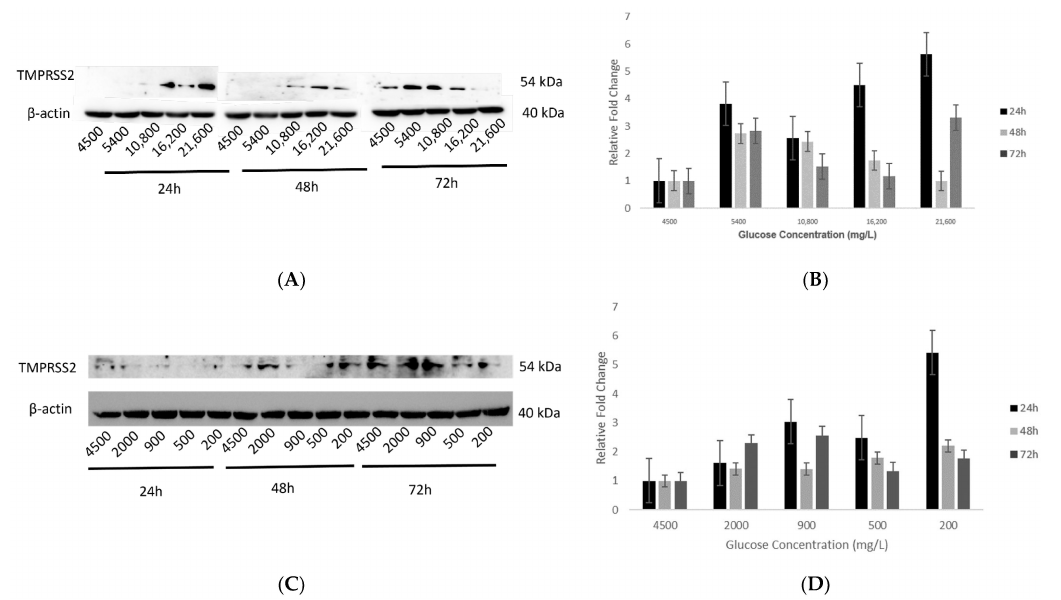
Figure 5. Protein expression of TMPRSS2 in hypothalamic neurons under various concentrations of glucose at different time points. ( A ) With increasing glucose concentrations (mg/L) of 5400, 10,800, 16,200, and 21,600, protein expression of TMPRSS2 (54 kDa) showed an increase after 24h, which with longer exposures of 48 and 72 h, decreased as compared to the control condition (4500 mg/L) which was not significant. ( B ) Histogram with relative fold change for TMPRSS2 (cid:48) s protein expression ( n = 3) with increasing glucose concentrations compared to loading control ( β -actin; 40 kDa). ( C ) With decreasing glucose concentrations (mg/L) of 2000, 900, 500, and 200, there was an increase in TMPRSS2 (cid:48) s protein expression after 24 h, whereas the opposite trend was observed after 48 h. However, after more prolonged exposure to 72 h, its expression first increased (at 2000 and 900 mg/L) and then decreased (at 500 and 200 mg/L concentrations), as compared to the control condition (4500 mg/L) but was not significant. ( D ) Histogram with relative fold change for TMPRSS2 (cid:48) s protein expression ( n = 3) with decreasing glucose concentrations compared to loading control ( β -actin). Data are represented as mean ± SEM. Full blot images are provided in Supplementary Materials (Figures S3 and